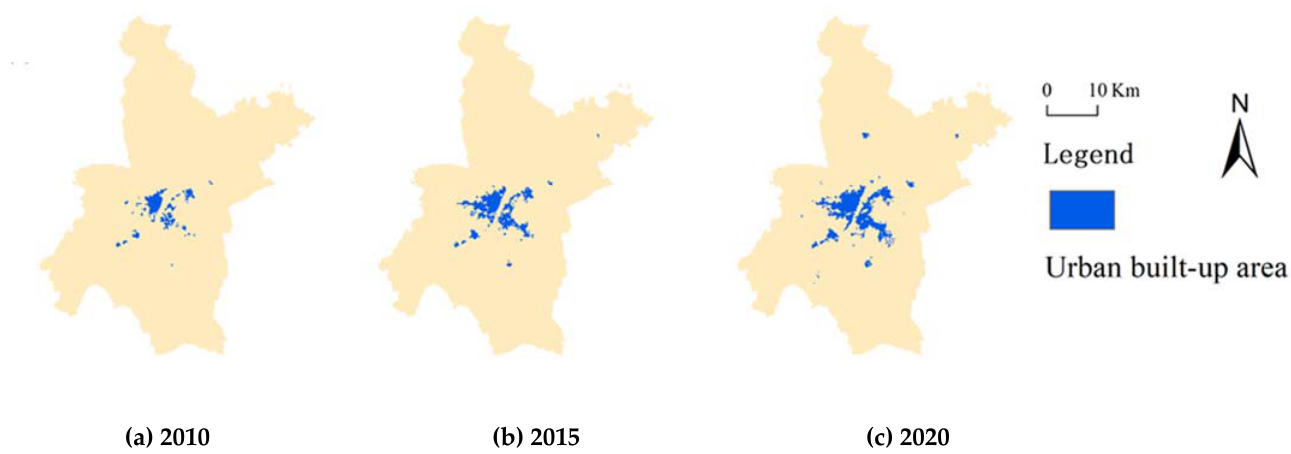
Figure 6. Urban built-up areas of Wuhan city in ( a ) 2010, ( b ) 2015, and ( c )